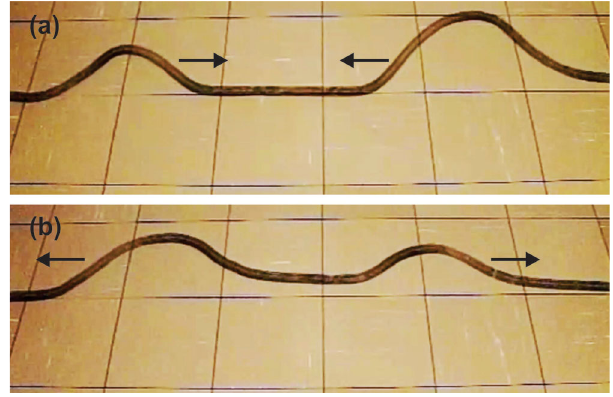
1. Observational experiment: Snapshots of the two